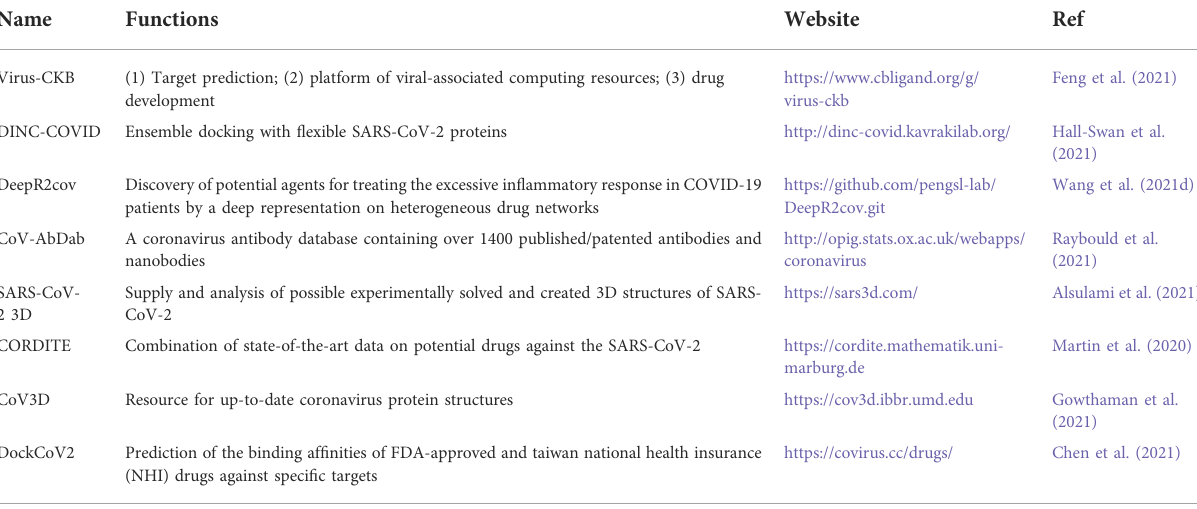
TABLE 1 Other computational tools developed for the analysis of COVID-19-related